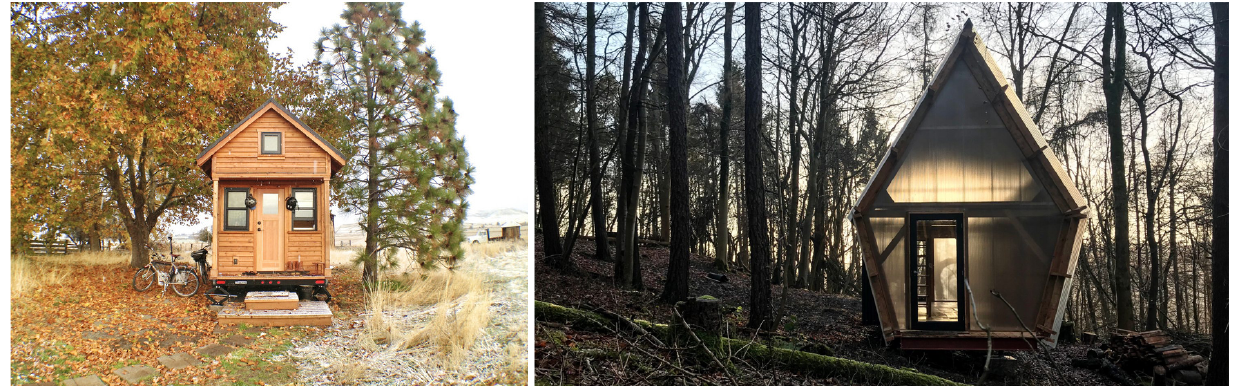
Figure 9. Examples of Tiny Houses. Sources: Stott (2015) and Block